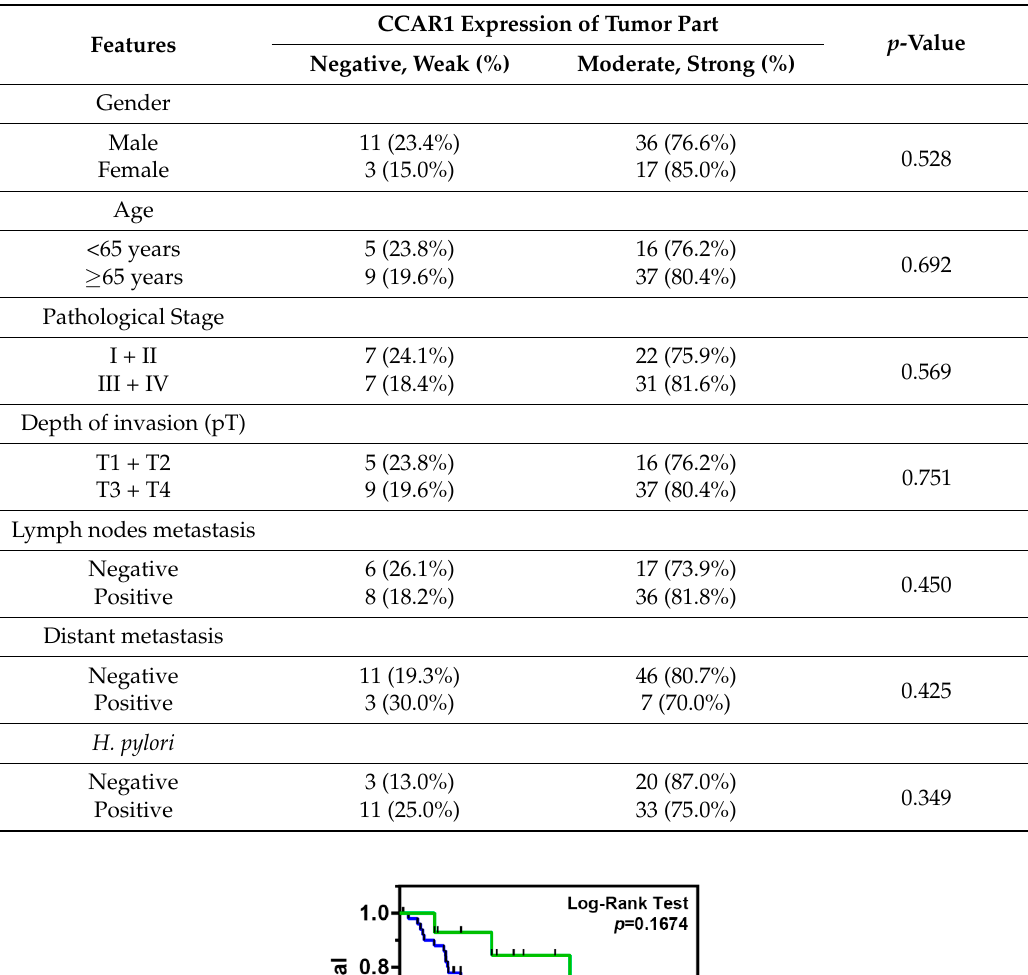
Table 2. Association between clinicopathological features and CCAR1 expression. Features